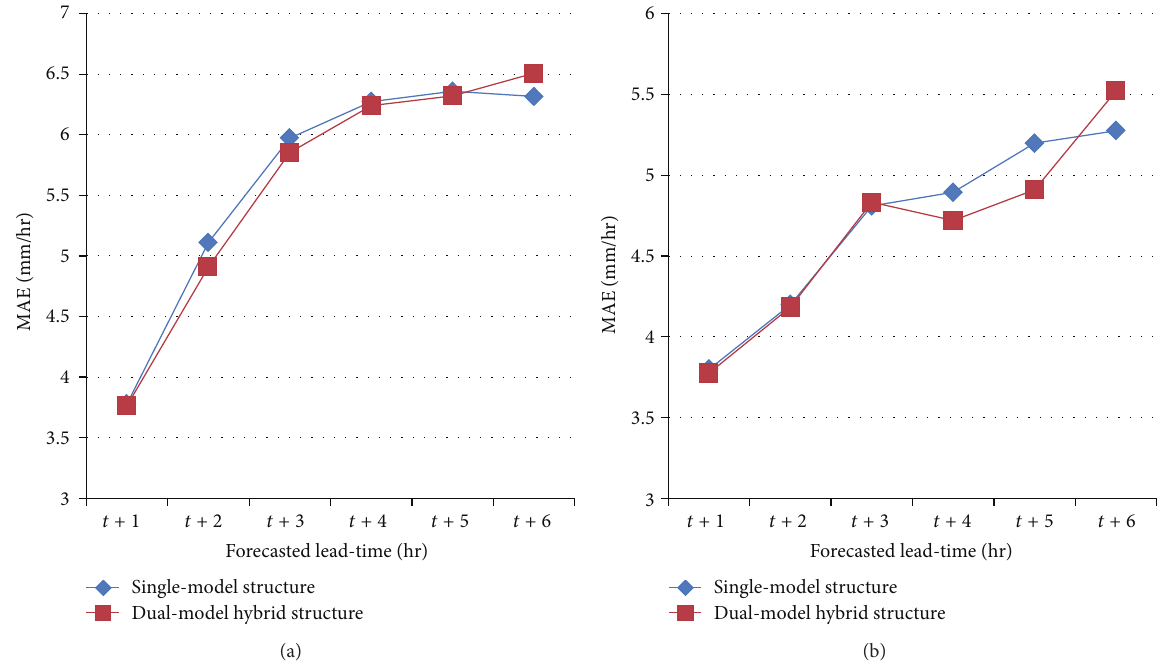
Figure 9: Comparison of the forecast performance of the single and hybrid ANFIS-based models at Yu-Feng station: (a) validation; (b)